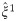
Representative phase portraits of the fast dynamics on the face Φ corresponding to the scenario of [40].The phase portraits are shown at three different ‘slow’ STD times. Green, orange and purple dots represent the stable, completely unstable and saddle equilibria, respectively. The blue lines illustrate segments of trajectory starting near ξ1. (a) The learned patterns ξ1 and ξ2 are stable for t < T0. (b) The bifurcation of a saddle point on the edge between ξ1 and ξ^1 happens for T0 < t < T1. (c) Pattern ξ1 has become unstable along the edge ξ1-ξ^1 whilst ξ2 is still stable for t > T1. The saddle point in the interior of Φ merges with the bifurcated equilibrium before (c) is realised.